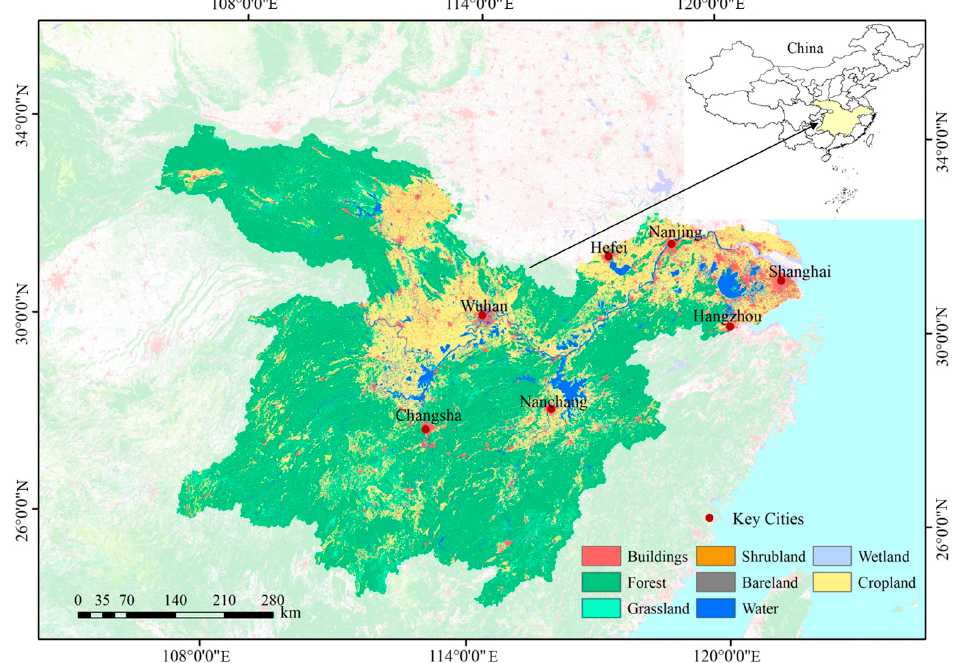
Figure 1. Location of the MLB in